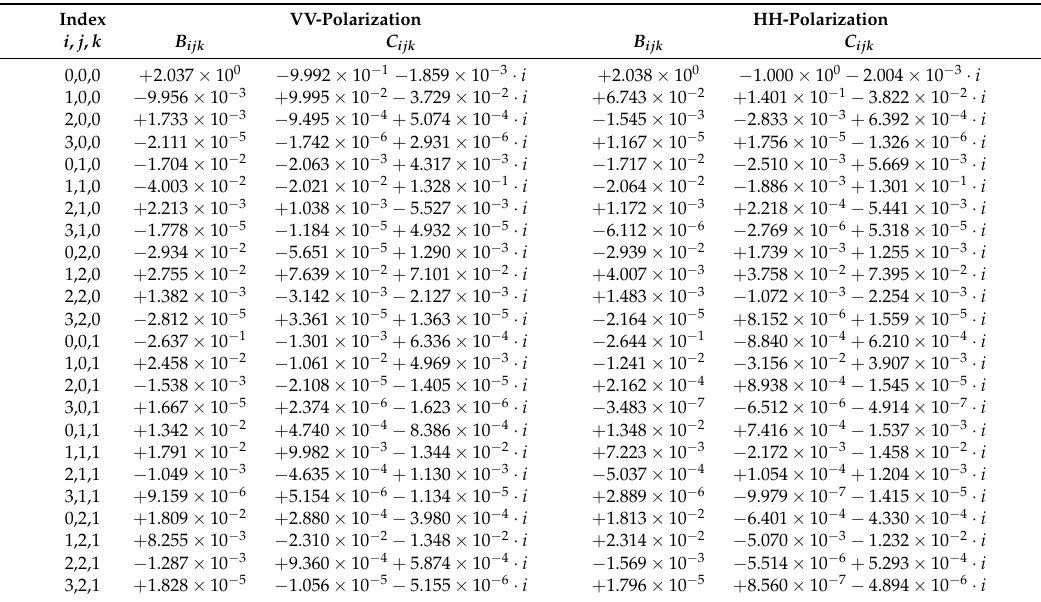
Table A1. Coefficients for the wind-sea-modulation transfer function (MTF), M ws (original empirical MTF [40] with nadir phase forced to 180 ◦ ).